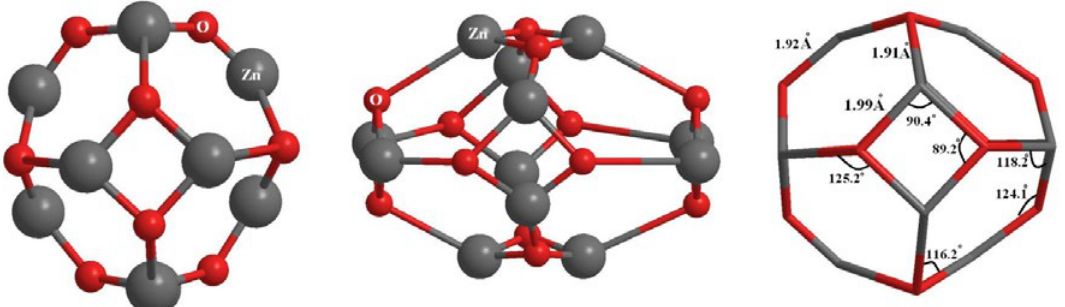
Figure 1 : Ball and stick model of the optimized geometric structure of Zn 12 O 12 -NC from different views.